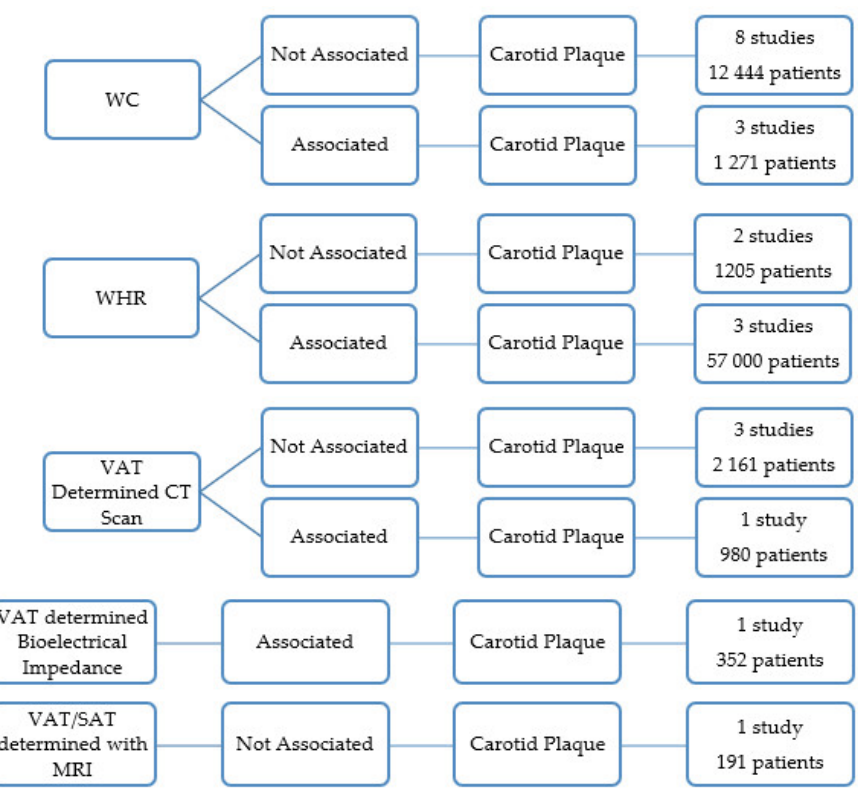
Figure 4. Results of the papers correlating visceral obesity with the presence of the carotid atherosclerotic plaques.